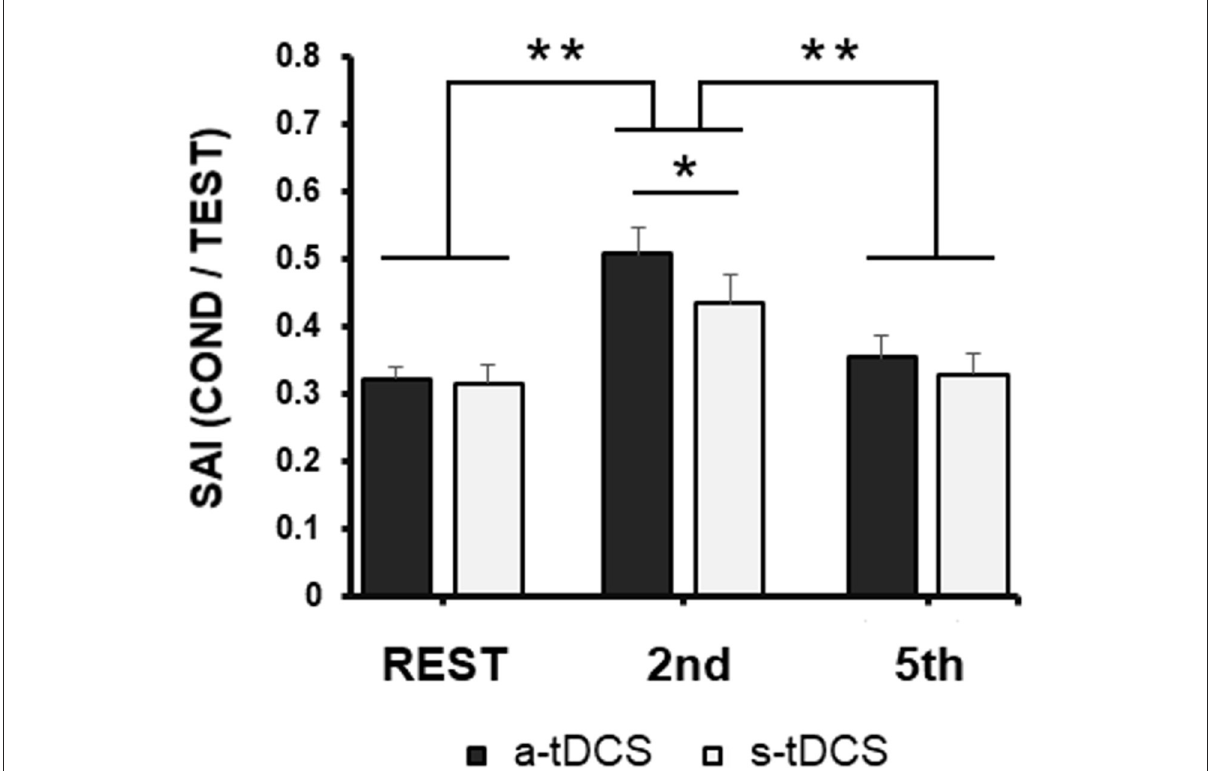
FIGURE2 Group averaged data (with standard error of the mean) of SAI modulation tested from FDI before 2nd and 5th fingers movements imagination or at rest during the experimental task, collected after a-tDCS (black columns) or s-tDCS (white columns). Vertical bars indicate SE; asterisks indicate the level of significance (* refers to p < 0.05, ** refers to p <